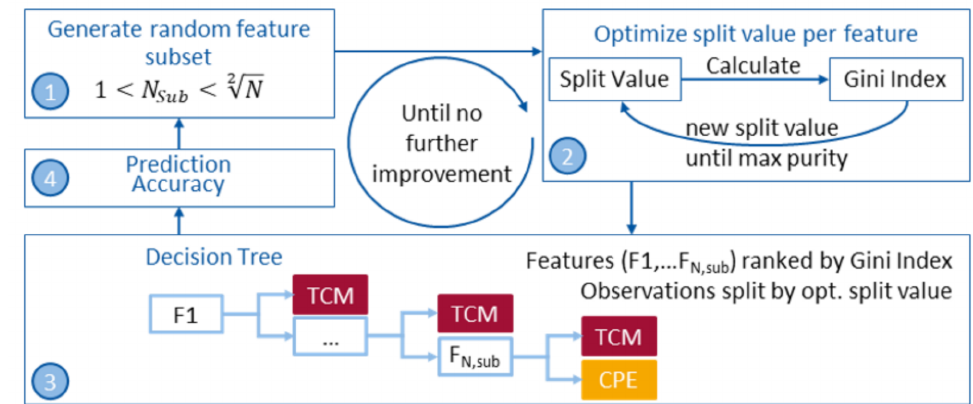
Figure 4. Forward Feature Selection Process. Sequentially adding features to the feature subset until no further improvement in prediction accuracy is